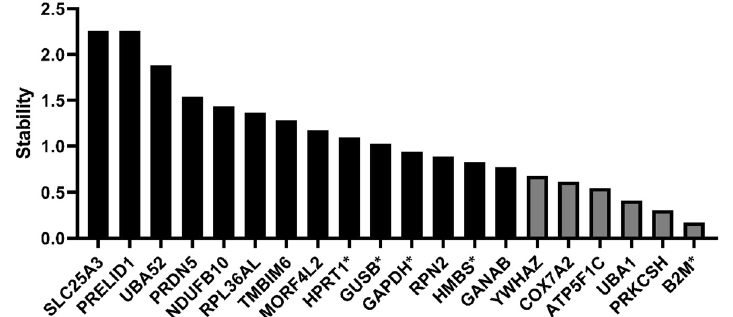
Figure 2. geNorm ranking of stability M value. Housekeeping genes are plotted based on their stability M value from the highest (left) to the lowest (right). Black bars are ideal housekeeping genes and grey bars are acceptable